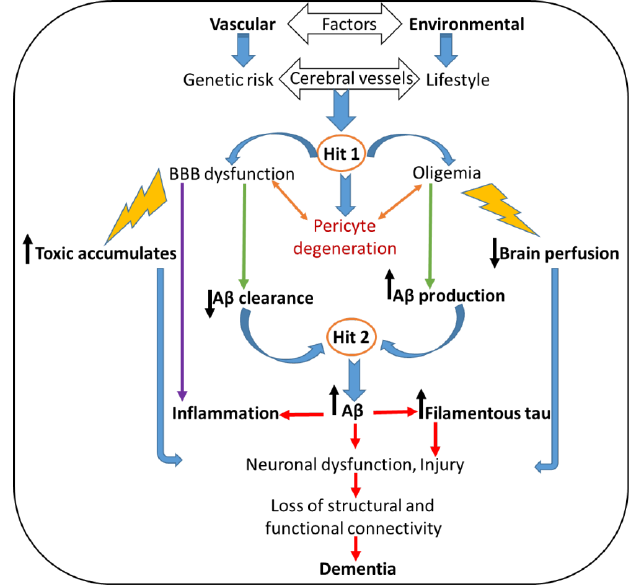
Figure 3. Replotting of a neurodegeneration pathway involved in AD pathogenesis, mediated by elevated levels of Aβ production, can independently and/or synergistically lead to the formation of filamentous Tau pathology [105].